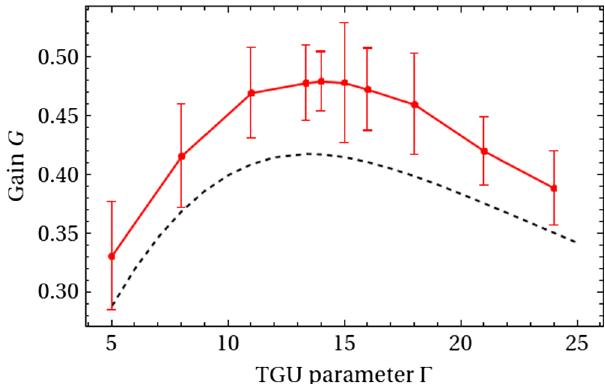
FIG. 3. Gain G vs TGU parameter Γ depicting results from numerical integration (black, dashed) and time-independent GENESIS simulation (red, solid). Error bars indicate 2 standard deviations of the shot-to-shot variation. Simulation results con- sistently overperform when compared to theory, likely due to the magnitude of gain G ∼ O ð 1 Þ surpassing the low-gain assumption of the analytical formula. Nevertheless, both models are con- sistent in the location of the gain optimum at Γ ¼ 13 . 3